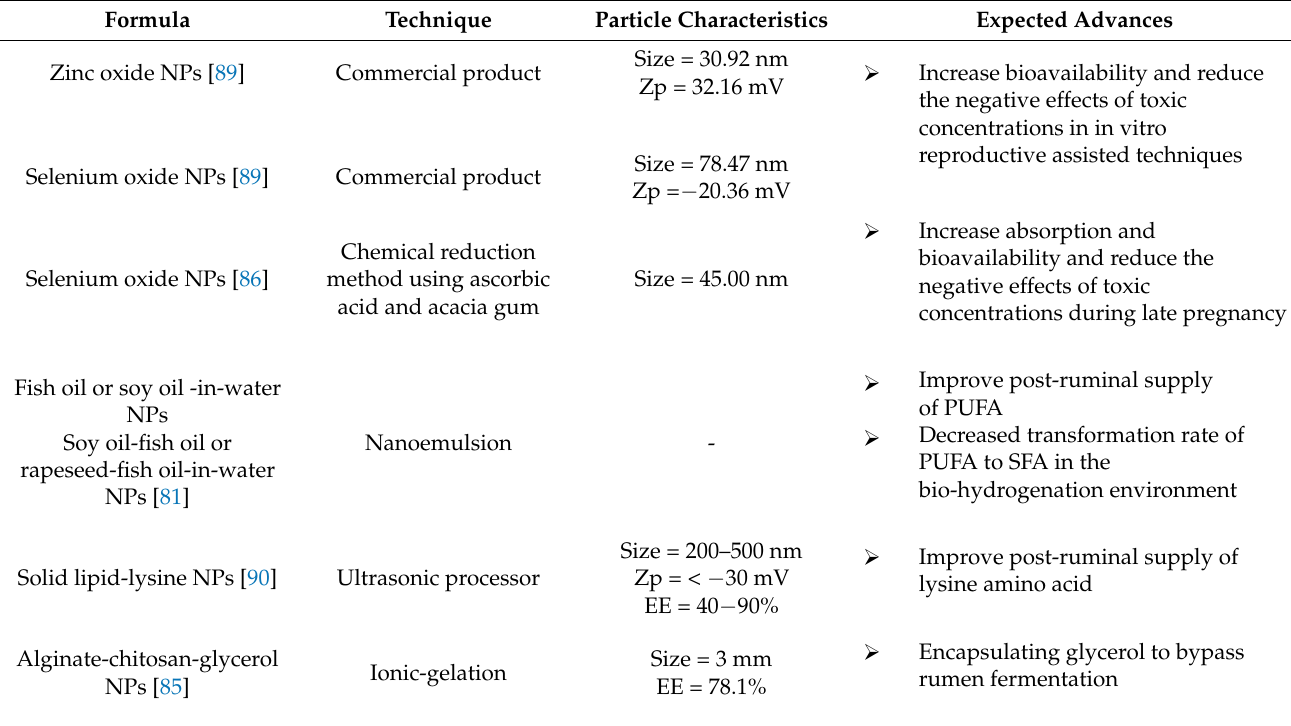
Table 1. Characteristics and expected advances by the implementation of nanotechnologies in the use of reproductive hormones for farm animals’ reproductive management. Figure Technique Particle Characteristics